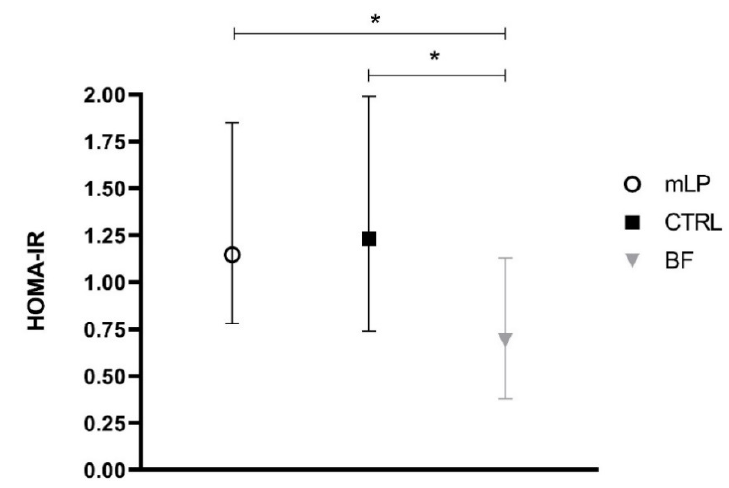
Figure 2. HOMA-IR at 4 months of age. Median (IQR), * p <